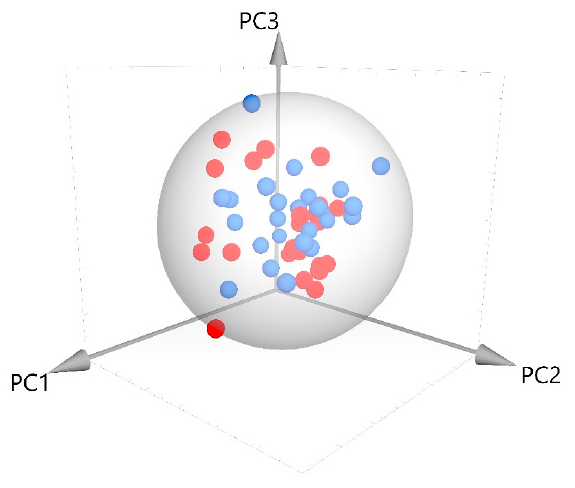
Figure 3. Projection plot of the samples in the space defined by the firsts three components.